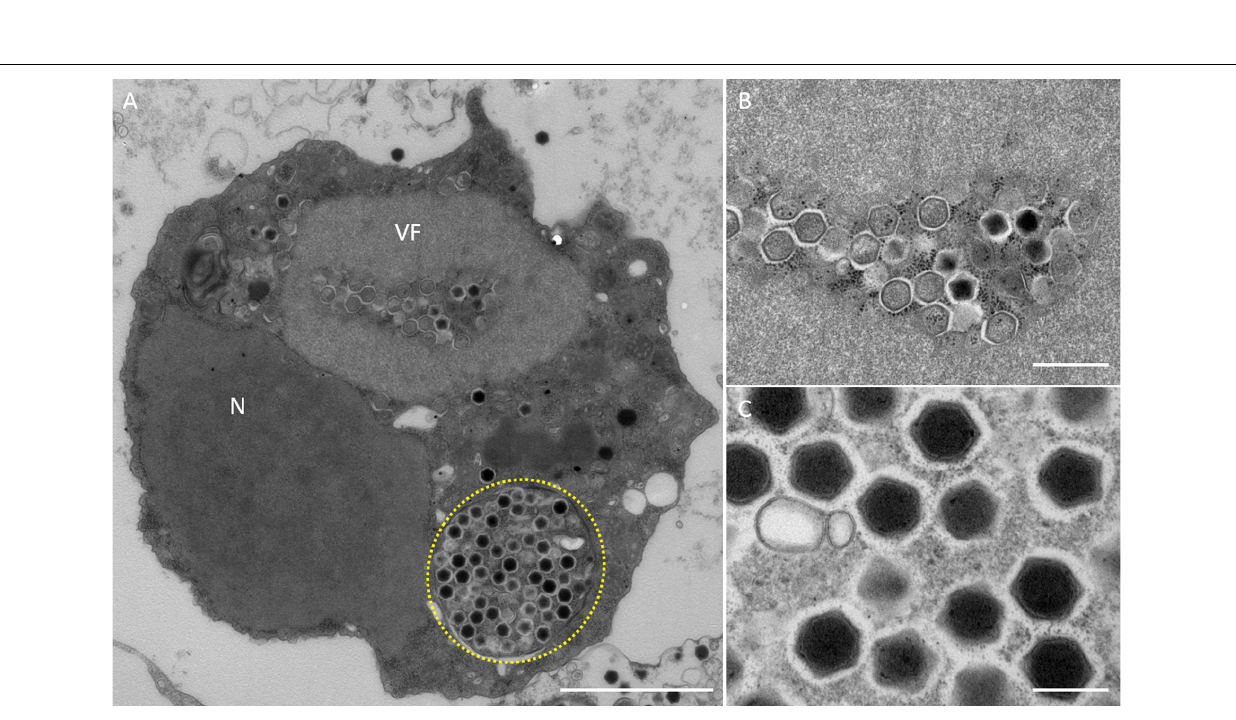
Frontiers in Microbiology |